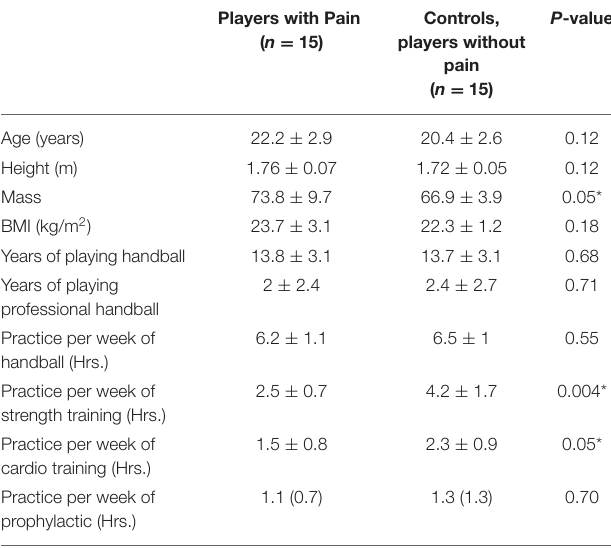
TABLE 1 | Anthropometry and training experience per group.